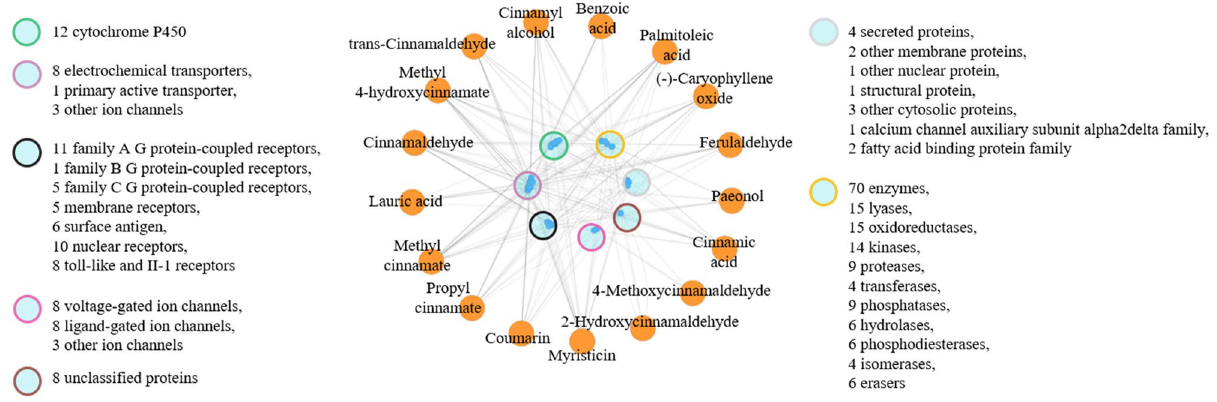
Figure 3. Analysis of cerebral cinnamon targets and corresponding components. The orange circles in the figure represent the active ingredients in the cinnamon water extract that can penetrate the BBB, and the circles with different colors in the middle represent different target types. The entire network graph represents the interaction between the compound and the